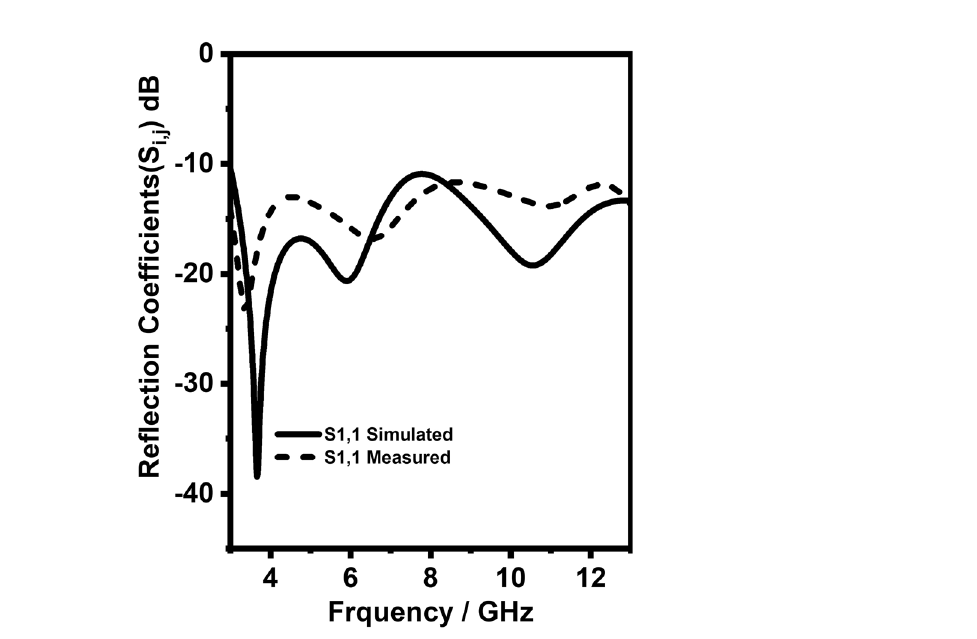
Figure 12. S-Parameters of UWB radiator (Simulated and